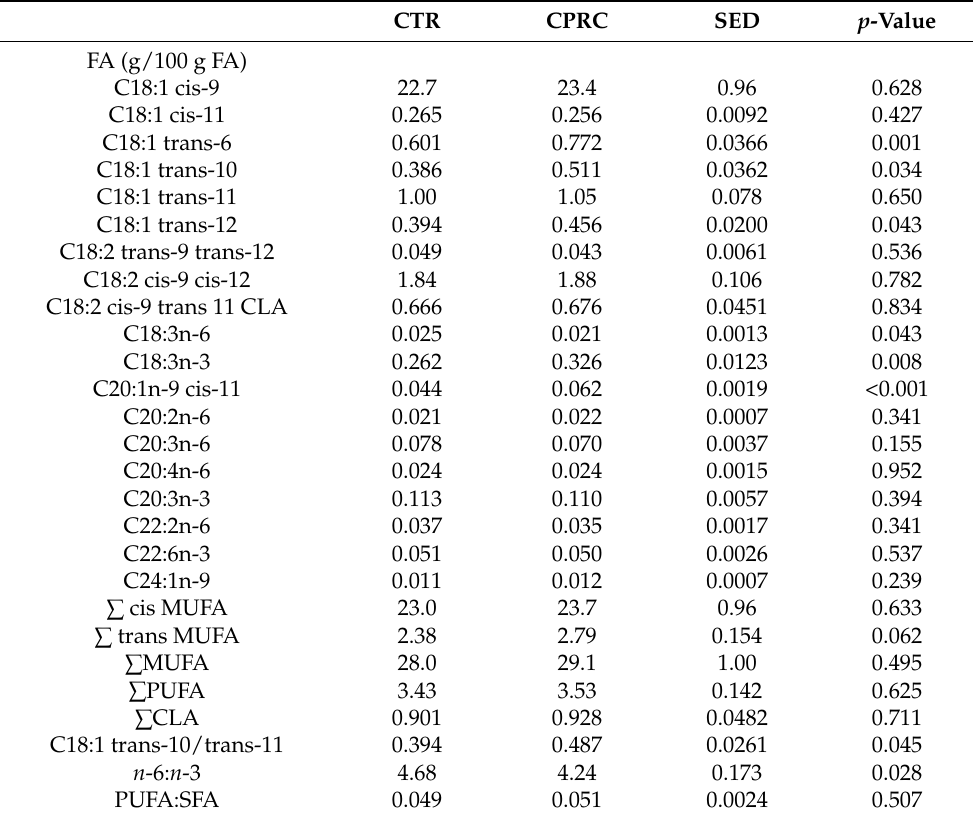
Table 8. Effect of including cold-pressed rapeseed cake in the concentrate of dairy cows on milk unsaturated fatty acids composition (LSM, n = 18). CTR CPRC